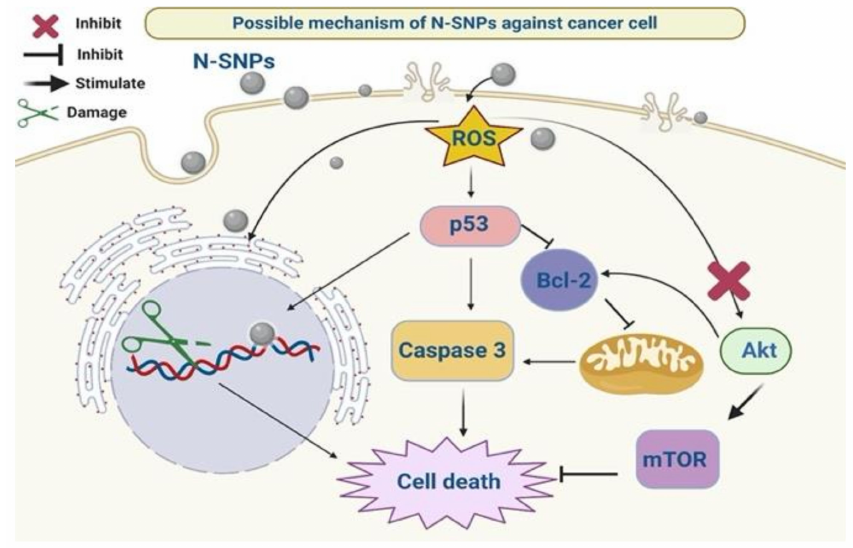
Figure 12. The possible molecular mechanism of N-SNPs against cancer